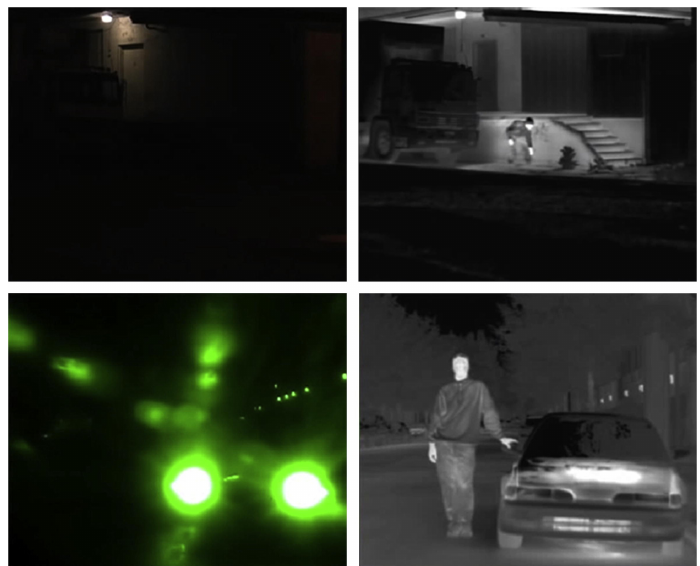
Figure 2. The left column shows images taken by a video camera and the right column show images of the same two scenes taken by an infrared camera. Reprinted/Adapted with permission from Ref. [21]. 2016 Elsevier.